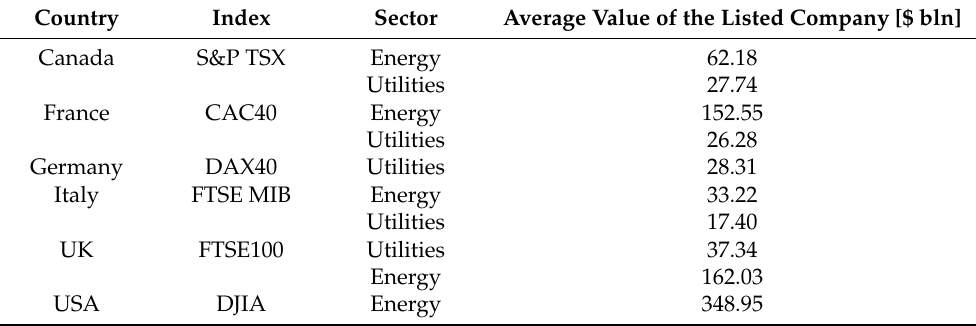
Table 4. Average values of the sector for Energy and